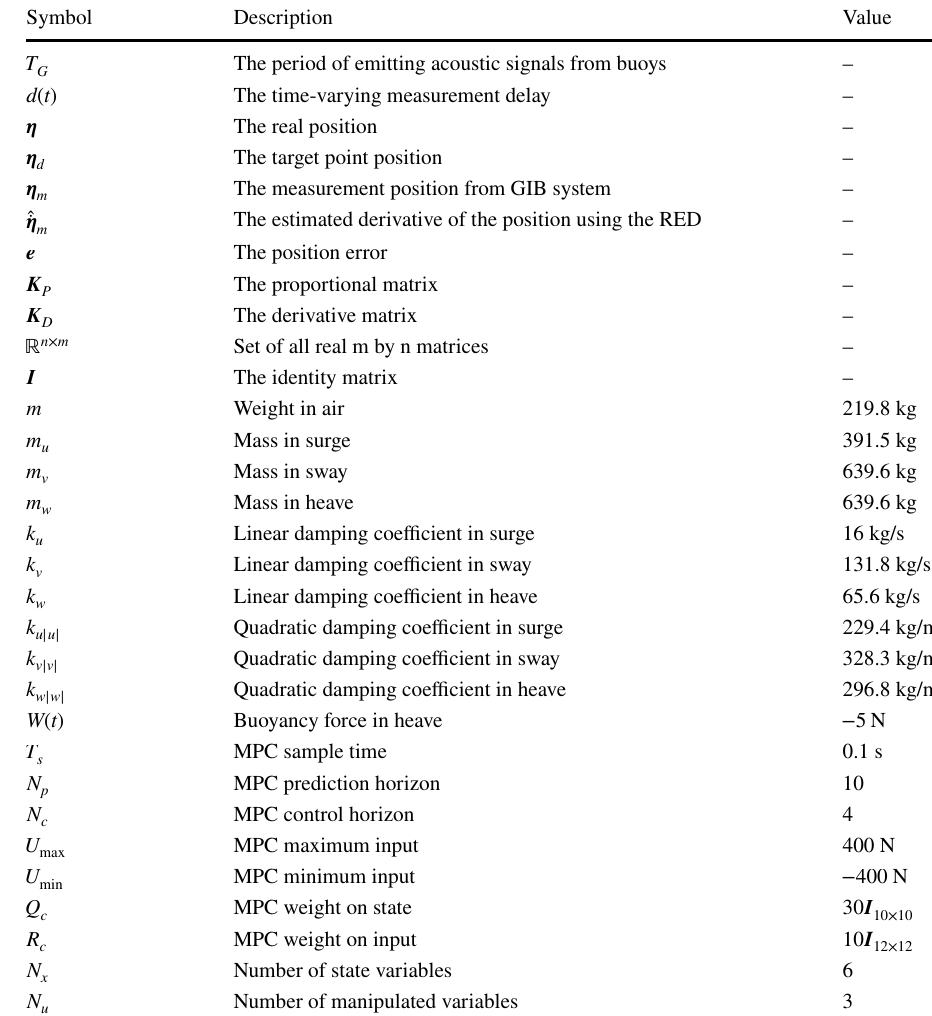
Table 1 The main